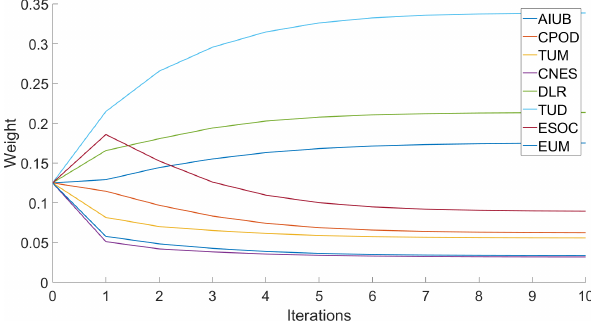
Figure 10. Weights of solutions as a function of number of itera-